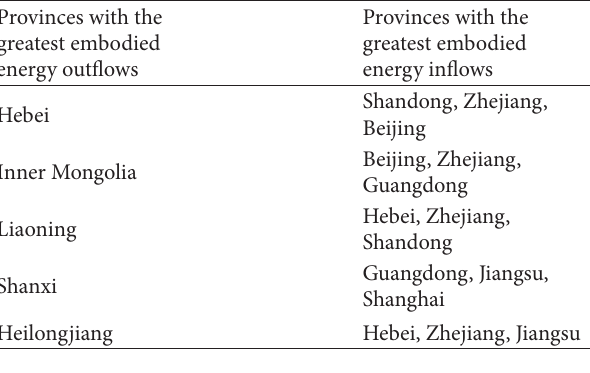
Table5:Destinationsofembodiedenergyoutflowsfromthetopfive provinces.